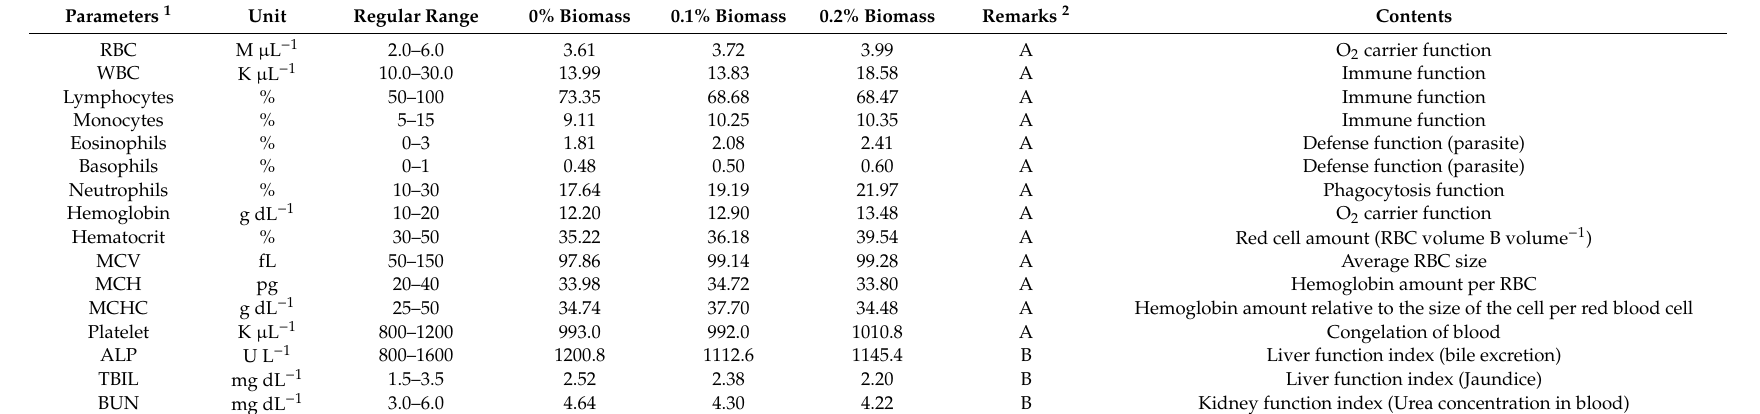
Table 3. E ff ect of dried H. pluvialis extracts on the physiological activity and immune system of